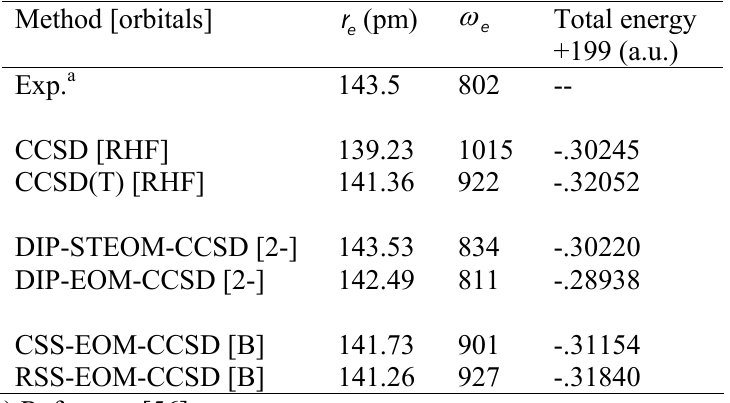
molecule (cc-pVTZ basis set). 2